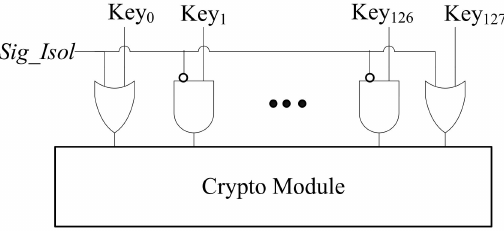
Figure 7. Isolating